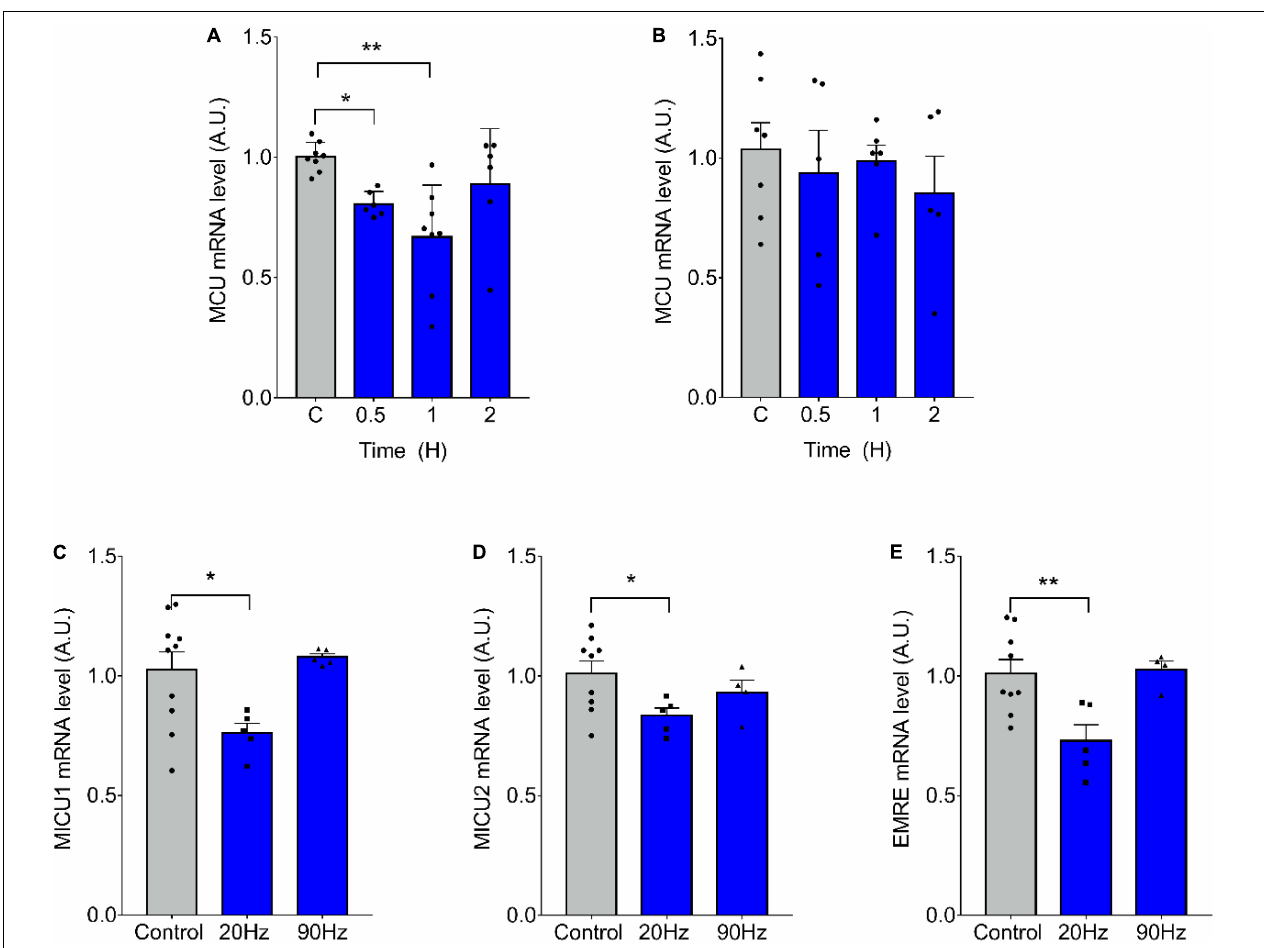
FIGURE 1 | Low-frequency electrical stimulation (ES) transiently reduces mRNA levels of MCU complex in skeletal muscle fibers. Muscle fibers isolated from the Flexor Digitorium Brevis ( fdb ) muscle were stimulated with 270 pulses, 0.3 ms each (A) at 20 Hz ( n = 6–8 per condition) or (B) 90 Hz ( n = 5–7 per condition). mRNA levels of MCU decreased 1h post-ES (A) ; while high-frequency stimulation produced no change (B) . The low frequency stimulation also decreased mRNA levels of MICU1 ( n = 5–10 per condition) (C) , MICU2 ( n = 4–9 per condition) (D) and EMRE ( n = 4–9 per condition) (E) 1 h post ES. For (A) using the Kruskal–Wallis test with post hoc Dunn’s was applied. Values are presented as mean ± SEM. 18S was used as normalizer. * p < 0.05; ** p < 0.01; *** p < 0.001.